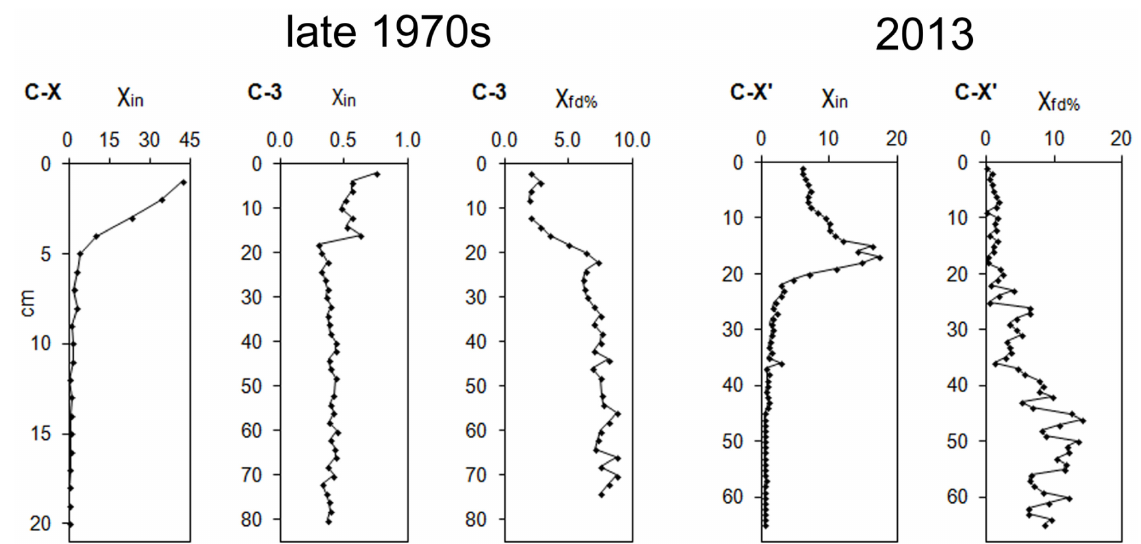
Figure 3. Mass specific magnetic susceptibility ( χ dependent magnetic susceptibility ( χ the late 1970s and 2013 from the Elefsis Gulf at distances 0.3 km from the steel mills